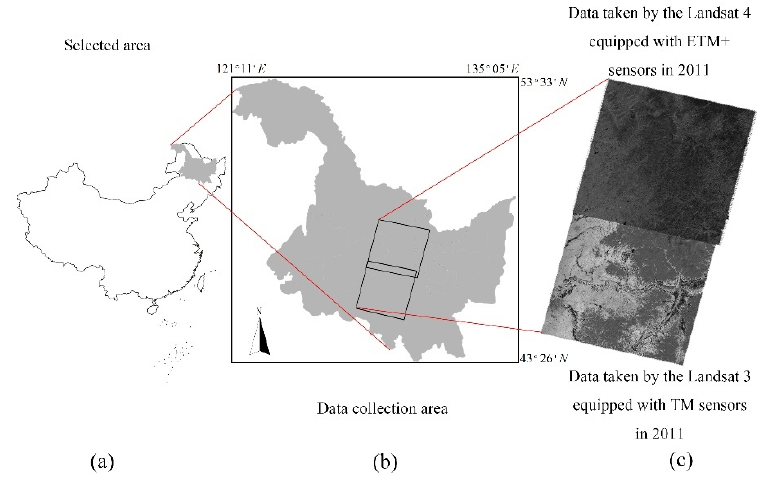
Figure 11. Image sources. ( a ) Selected area. ( b ) Image collection area. ( c ) Image obtained.